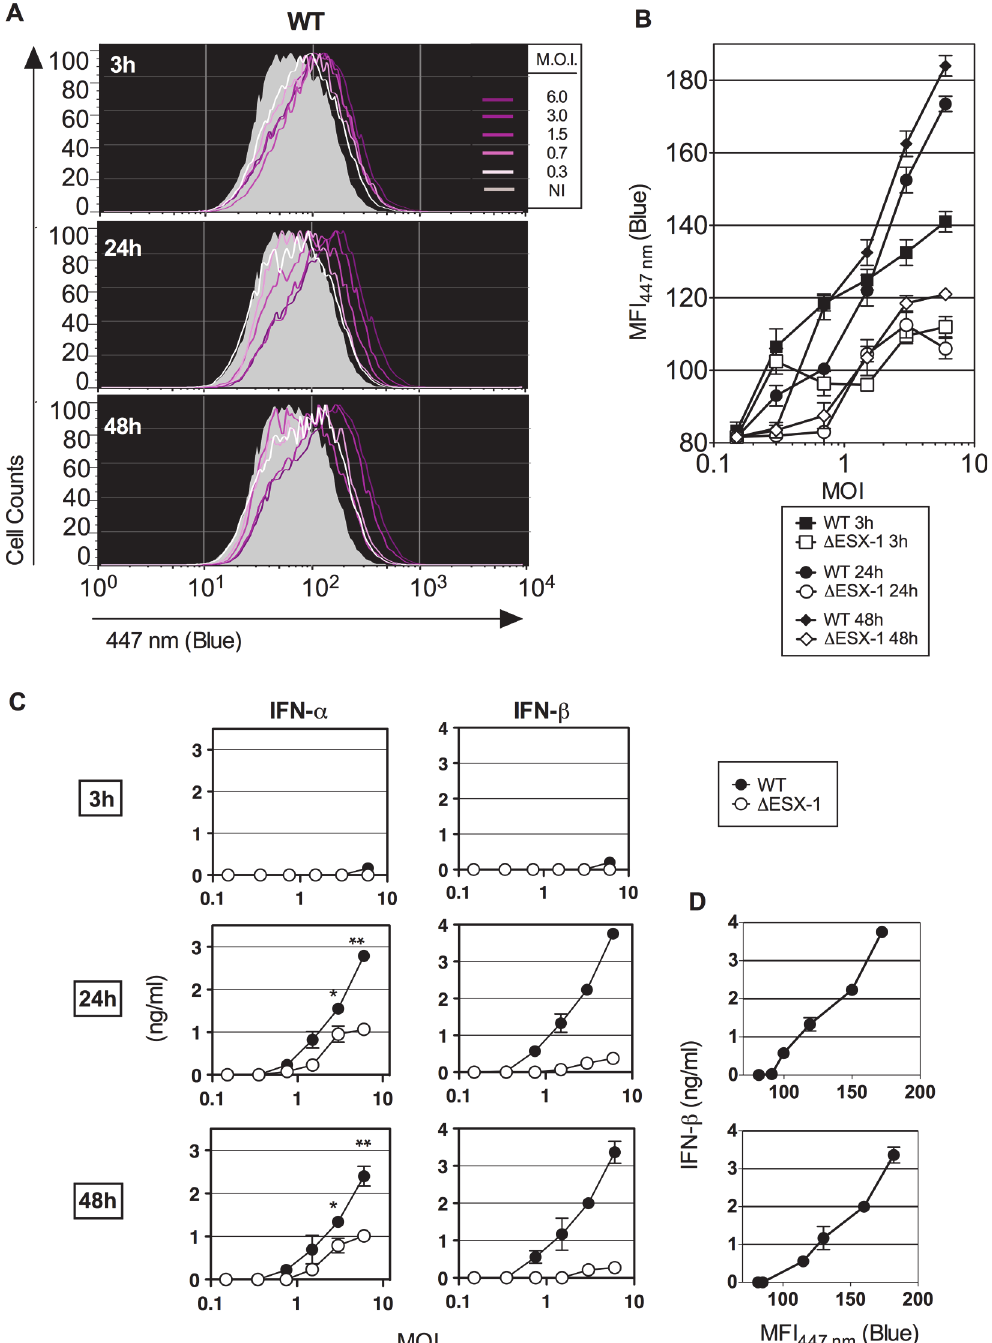
Fig 3. Early Mtb -mediated phagosomal rupture, relationship with secretion of type I IFNs. (A) BM-DC were infected with Mtb WT at different MOI and the phagosomal rupture was assessed by CCF-4 staining at early time points of 3, 24 and 48 hpi. (B) MFI 447 nm of the infected cells at each time point and for different MOI of WT or Δ ESX-1 strain. (C) IFN- α and- β concentrations, as quantified in the supernatants of the same infected cells by ELISA. * , ** = statistically significant, p < 0.01 or p < 0.001, respectively, as determined by the Student's t test. (D) Linear relationship between the amounts of IFN- β produced and Mtb - induced phagosomal rupture in BM-DC. Shown are representative data from 2 independent experiments.